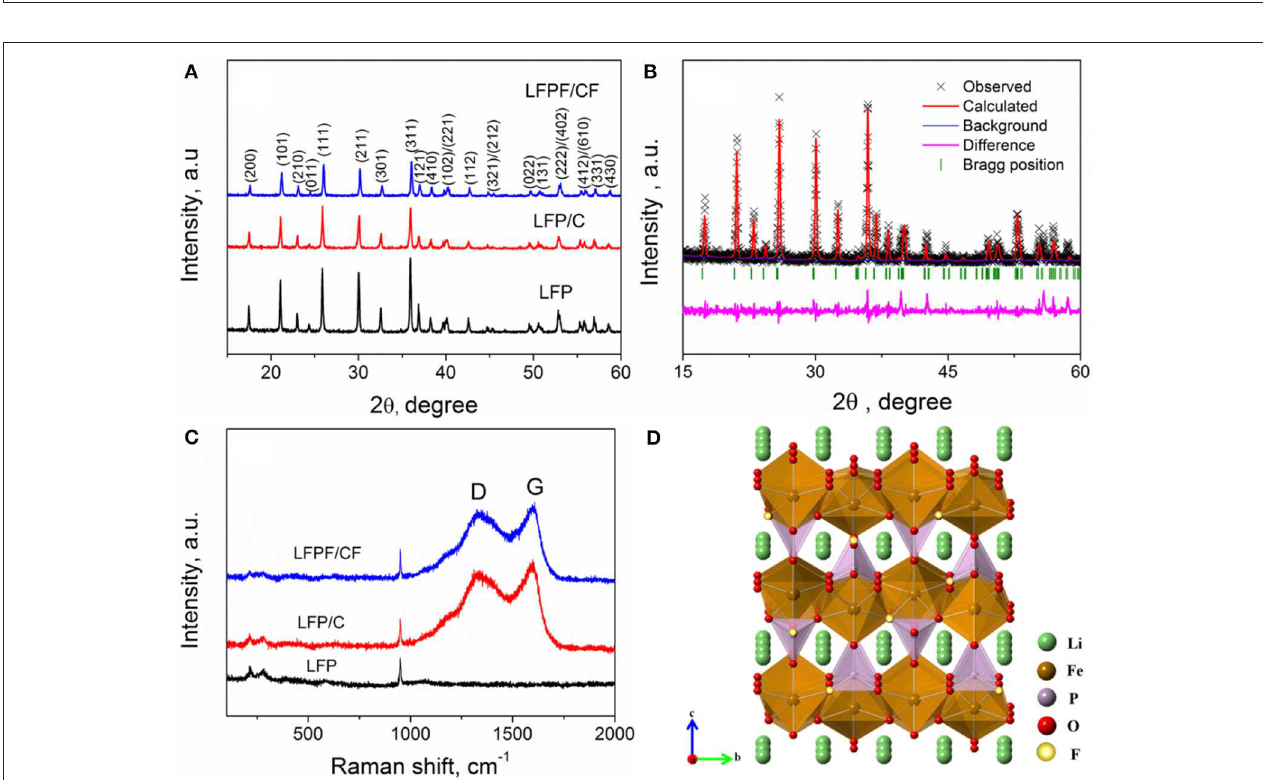
the HRTEM image shows that pure LFP exhibits a smooth surface without carbon layer ( Figure 6A 2 ). Figures 6B 1 ,B 2 shows the TEM and HRTEM images of LFP/C. The